Question: Write a single sentence explaining what this figure depicts.
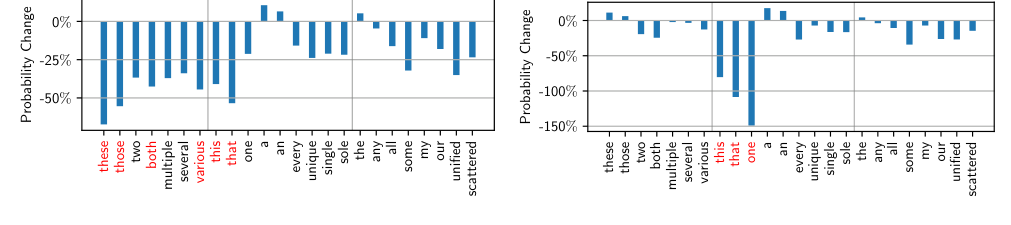
Answer: Despite w11 1835’s high occurrence in Det-N pairs with this and that, because its 3% strong appearance in Det-N pairs with these, it is not a singular grammatical number KN.